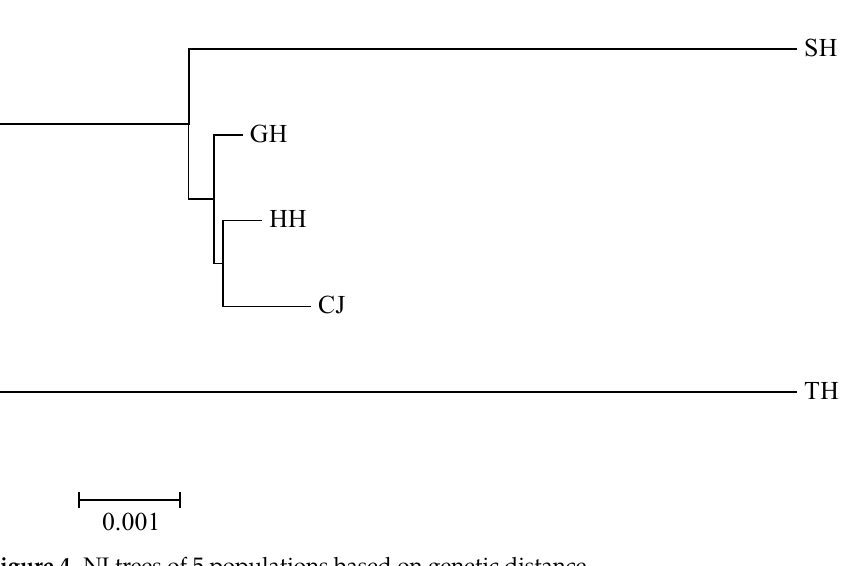
Figure 5. Mismatch distribution of C. alburnus based on COI gene sequences.